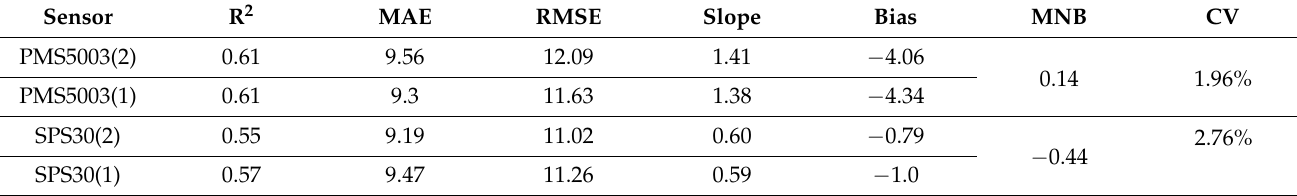
Table 4. Performance indicators of each copy of the sensors in relation to the reference